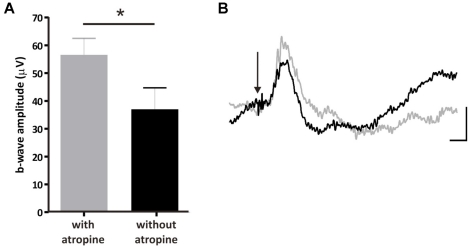
Atropine augments an ERG b-wave preserved in TKO mice.(A) b-wave amplitude of flash ERG responses in the presence and absence of atropine drops. A small but significant increase in the ERG b-wave amplitude was apparent following application of atropine drops (data presented as mean±SEM; n = 5 for each group). This is demonstrated in the average of all ERG responses in each group, shown in (B), atropine treated shown in grey, and untreated in black (scale bars: y-axis = 25 µV, x-axis = 50 ms; n = 5 for each group).